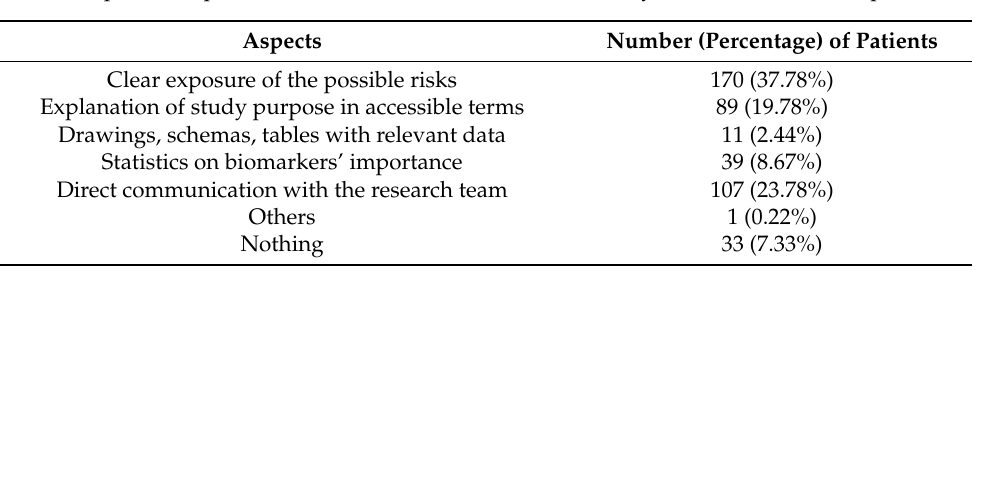
Table 4. Important aspects for those involved in a biomarker study (Choose one or two